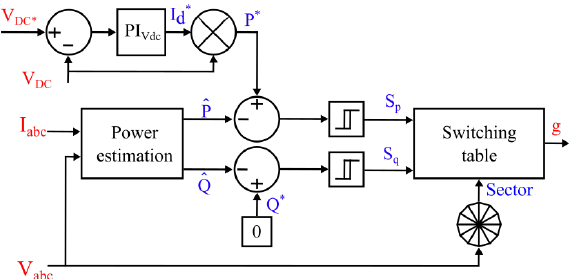
Figure 26. Direct Power Control of AFE